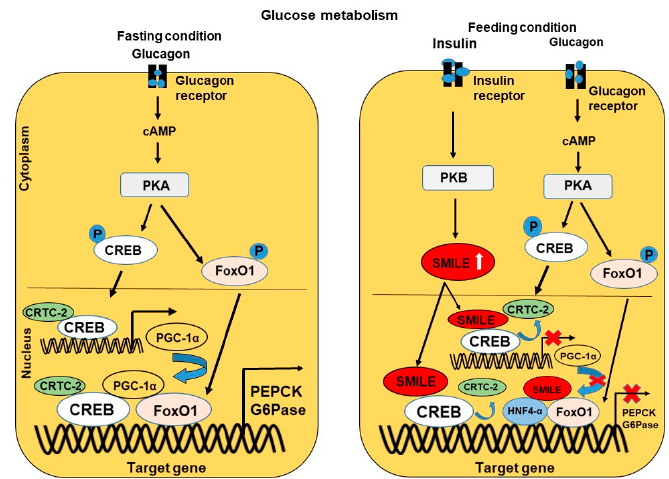
Figure 4. The role of SMILE in regulating glucose metabolism. SMILE is an inducible transcription factor that binds to various transcription factors, such as FoxO1, CREBH, STAT ‐ 3, nuclear receptors, SREBP ‐ 1c, CREB, and HNF4 α , which are activated by the signals of various liver metabolic pathways, including glucose, lipid, and iron. Glucose metabolism involves fasting and feeding conditions and involves the action of the hormones insulin and glucagon. These hormones regulate the metabolic signaling pathways via PkB/Akt and activate the transcription factors through phosphorylation, resulting in the regulation of gluconeogenic genes. During fasting, glucagon activates cAMP, which in turn activates the transcription factors CREB and FoxO1 via the PKA pathway. CREB, along with the binding of the coactivator CRTC ‐ 2, activates the transcription of PGC ‐ 1 α , which acts as a coactivator for other transcription factors. In contrast, during feeding conditions, insulin induces SMILE via the PKB pathway and inhibits the action of CREB by competing with CRTC ‐ 2, inhibiting the action of PGC1 α on other transcription factors and inhibits the transcription of gluconeogenic genes involved in glucose metabolism.